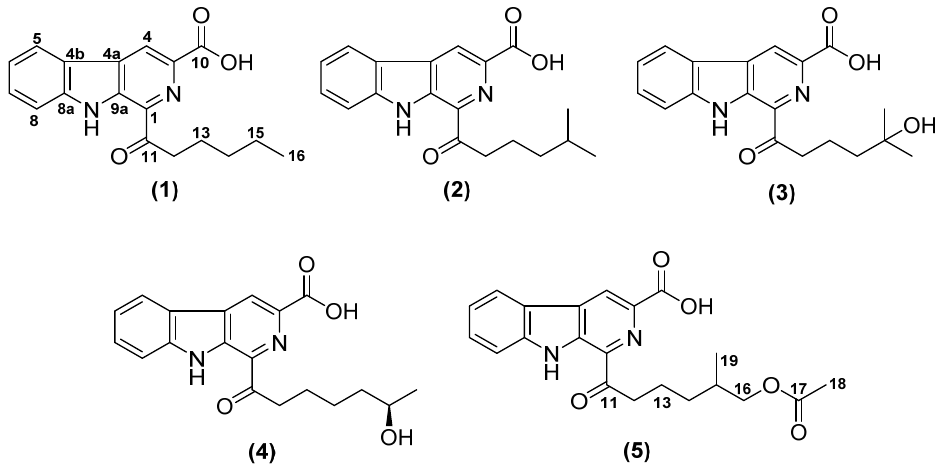
Figure 1. Structures of nonocarbolines A-E ( 1 – 5 ).